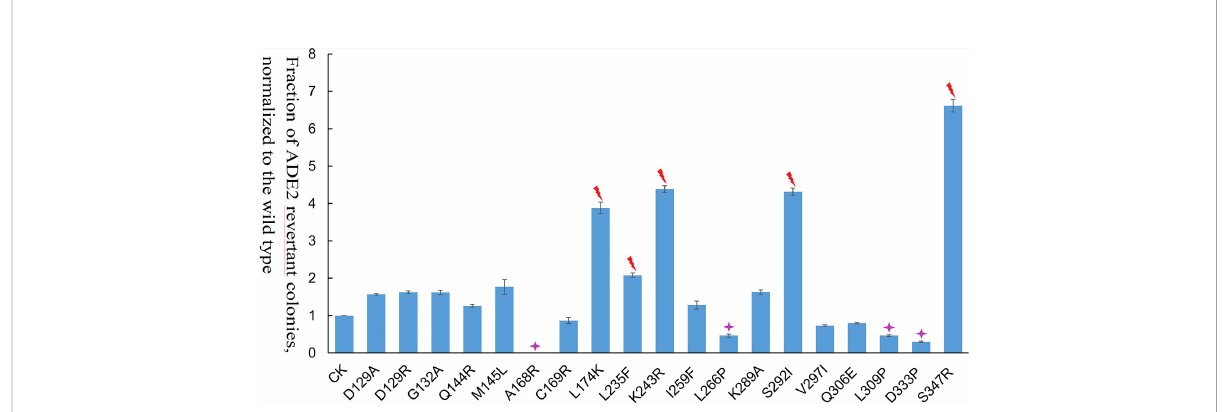
FIGURE 4 Transposition frequencies catalyzed by Ppmar2 transposase mutants (CK is the wild type Ppmar2 transposase). The mean excision frequency of the 19 Ppmar2 mutants was normalized by that of the wild type. Y-axis represents the fraction of ADE2 revertant colonies, normalized to the wild type. Each excision assay was conducted with six biological replicates. The transposase mutations were marked by red heart shapes